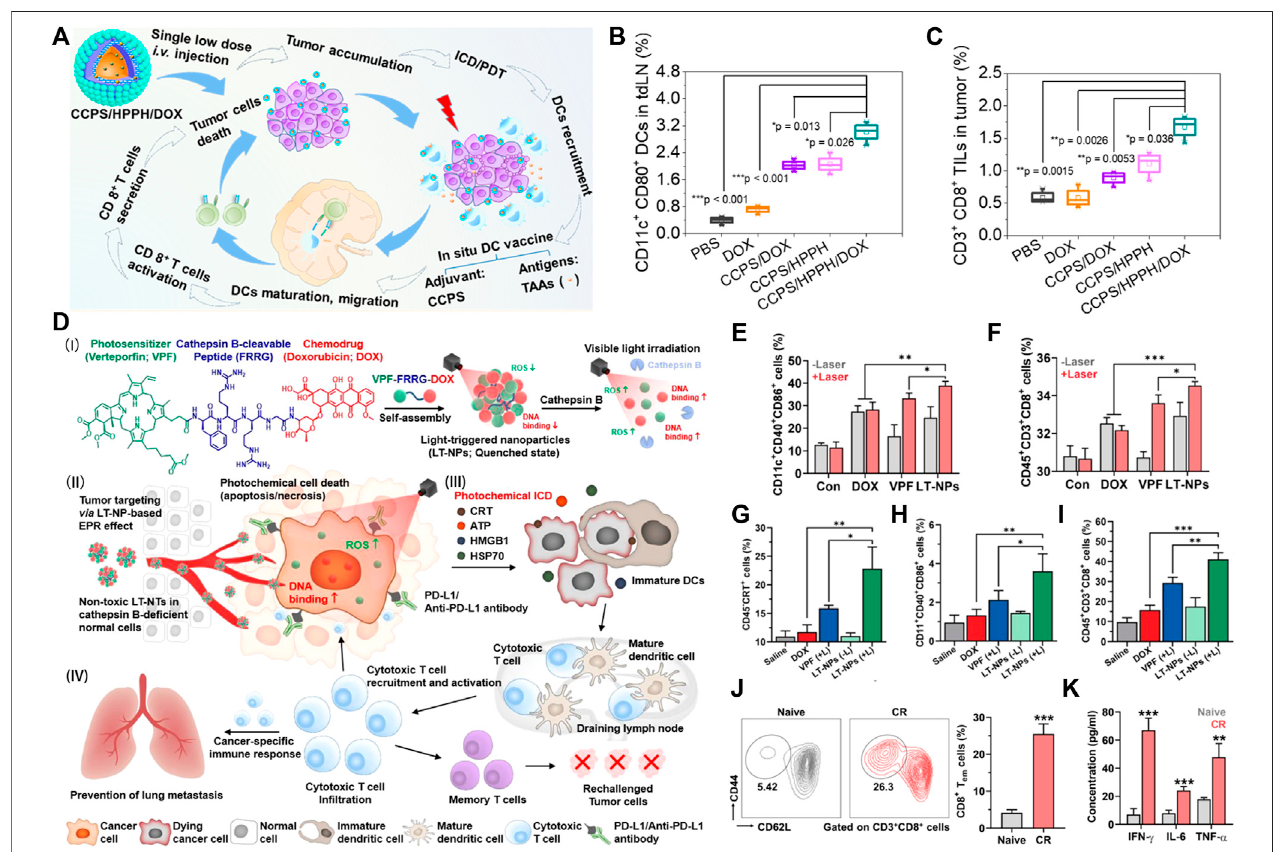
FIGURE 3 | Example of nanomedicine-based PDT to activate adaptive immune responses. (A) Schematic illustration of an in situ DC vaccine exploiting chimeric cross-linkedpolymersomes(CCPS)asadjuvantcombinedwithtumor-associatedantigens(TAAs)inducedbyPDTandICDforMC38colorectalcancerimmunotherapy. (B) Activated DC ratio in tumor-draining lymph nodes (tdLNs) for mice treated with different nanoformulations ( n = 3). (C) Tumor in fi ltrating lymphocytes in tumor sites after treatment( n =3) (Yang et al.,2019b). (D) Schematicillustration ofvisible-light-triggeredprodrug nanoparticles (LT-NPs) combined chemotherapy and PDTto potentiatecheckpointblockadecancerimmunotherapy. (E,F) Percentageof (E) maturedDCs(CD11c+CD40 + CD86 + )and (F) cytotoxicTcells(CD45 + CD3 + CD8 + )in lymphocytes after coculture with culture medium containing CT26 cells treated with DOX, VPF, or LT-NPs in the presence or absence of light irradiation ( n = 5). (G – I) Percentage of (G) CRT-positive cancer cells (CD45 − CRT+), (H) tumor-in fi ltrating matured dendritic cells (CD11c + CD40 + CD86 + ), and (I) tumor-in fi ltrating cytotoxic Tcells(CD45 + CD3 + CD8 + )onday7aftertreatments( n =5). (J) Percentageofspleniceffector/memoryTcellsamongtheCD8 + Tcells(CD3 + CD8 + CD44 + CD62L low